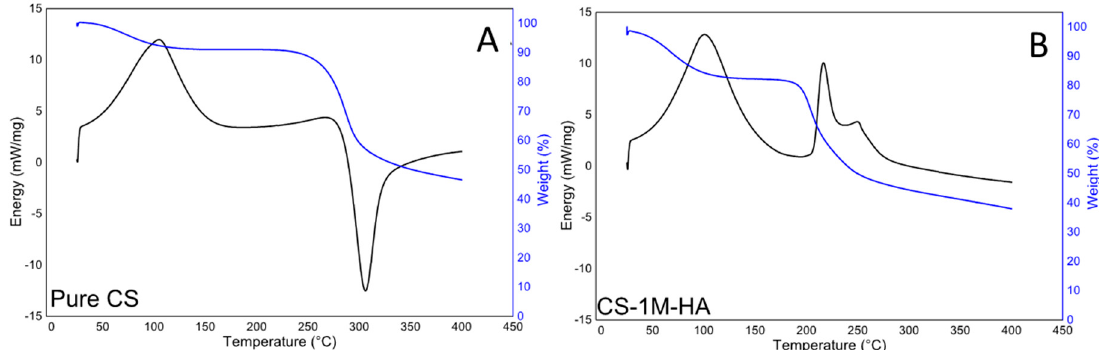
Figure 4. ( A ) TG and DSC curves for the thermal degradation of pure chitosan; ( B ) degraded (24 h, 80 °C) CS-1M-HA.